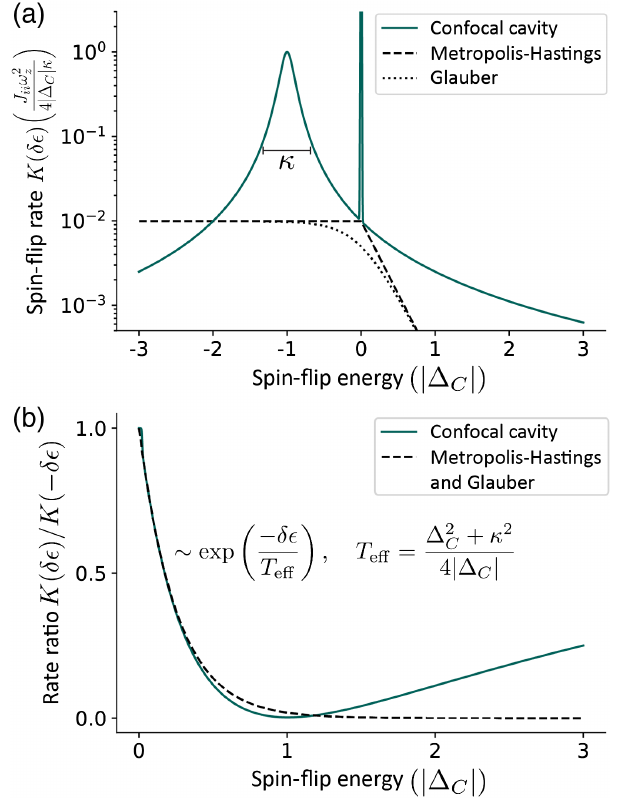
FIG. 8. (a) The spin-flip rate function K ð δϵ Þ in the confocal limit (solid line) versus spin-flip energy δϵ . Units are in terms of the pump-cavity detuning j Δ . Rates for Metropolis-Hastings C j (dashed line) and Glauber (dotted line) dynamics are also shown. (b) Ratio of energy-decreasing to energy-increasing spin-flip rates K ð(cid:2) δϵ Þ versus spin-flip energy (solid line). Comparing finite-temperature Metropolis Hastings dynamics (dashed line) to the actual cavity dynamics allows one to identify a